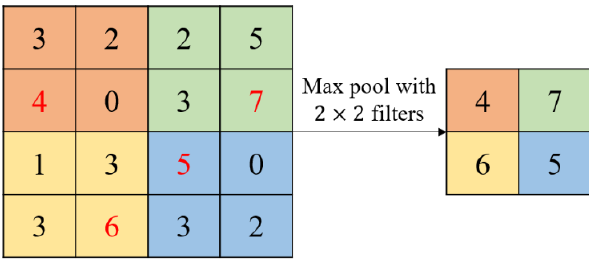
Figure 2. Max pooling transformation.